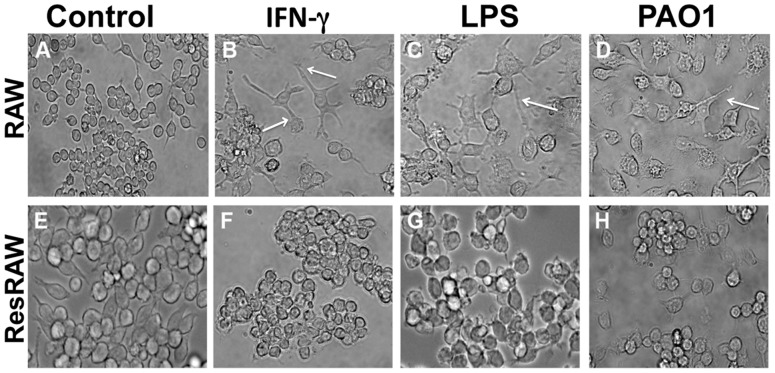
Morphological changes of naïve and resistant RAW 264.7 cells.Both naïve and resistant cells were exposed to g-interferon (25 ng/ml), soluble LPS (2 mg/ml) and PAO1 (MOI 10). After 1 h they were returned to culture for 48 h. The large differences of responsiveness of between the naïve and resistant cells are indicated by arrows. The naïve cells upon exposure to g-interferon, LPS, and PAO1 have extended processes and appear vacuolated, whereas the appearance of the resistant cells upon treatment does not differ from that of untreated control cells.